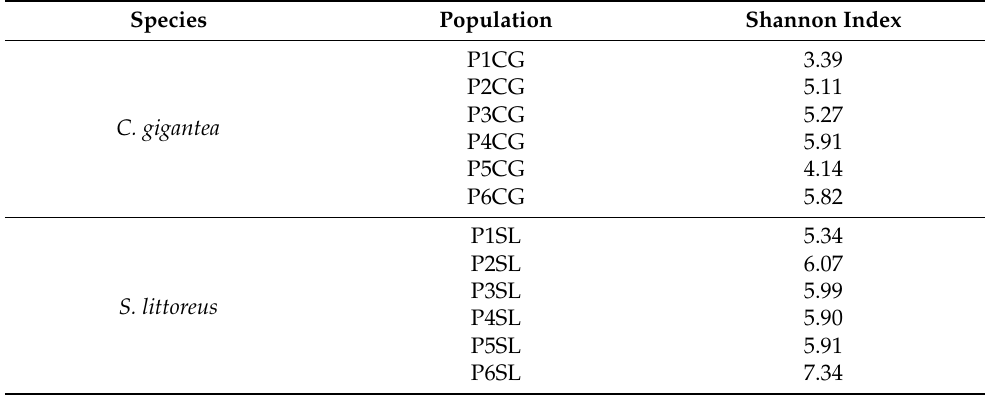
Figure 2. Bacterial taxonomic composition and relative abundance at phylum level. ( A ) Relative abundance of bacteria associated with the root of S. littoreus across six different sampling popula- tions at phylum level. ( B ) Relative abundance of bacteria associated with the root of C. gigantea across six different sampling populations at phylum level. Abbreviations of sampled populations: P — Population (Population 1 to 6, P1 to P6), CG — C. gigantea , SL — S. littoreus . Table 1. Species alpha diversity in sampling populations as measured by Shannon